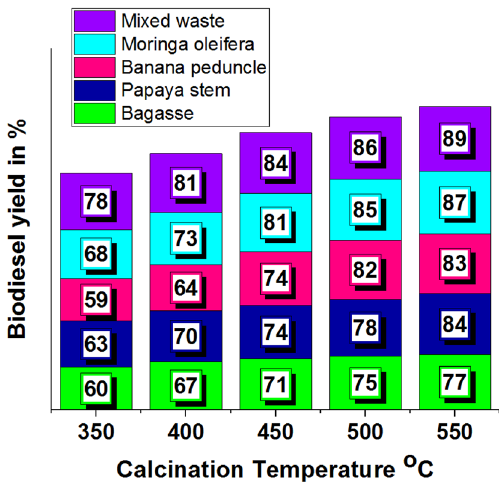
Figure 3. Comparison of biodiesel yield with different plant waste.